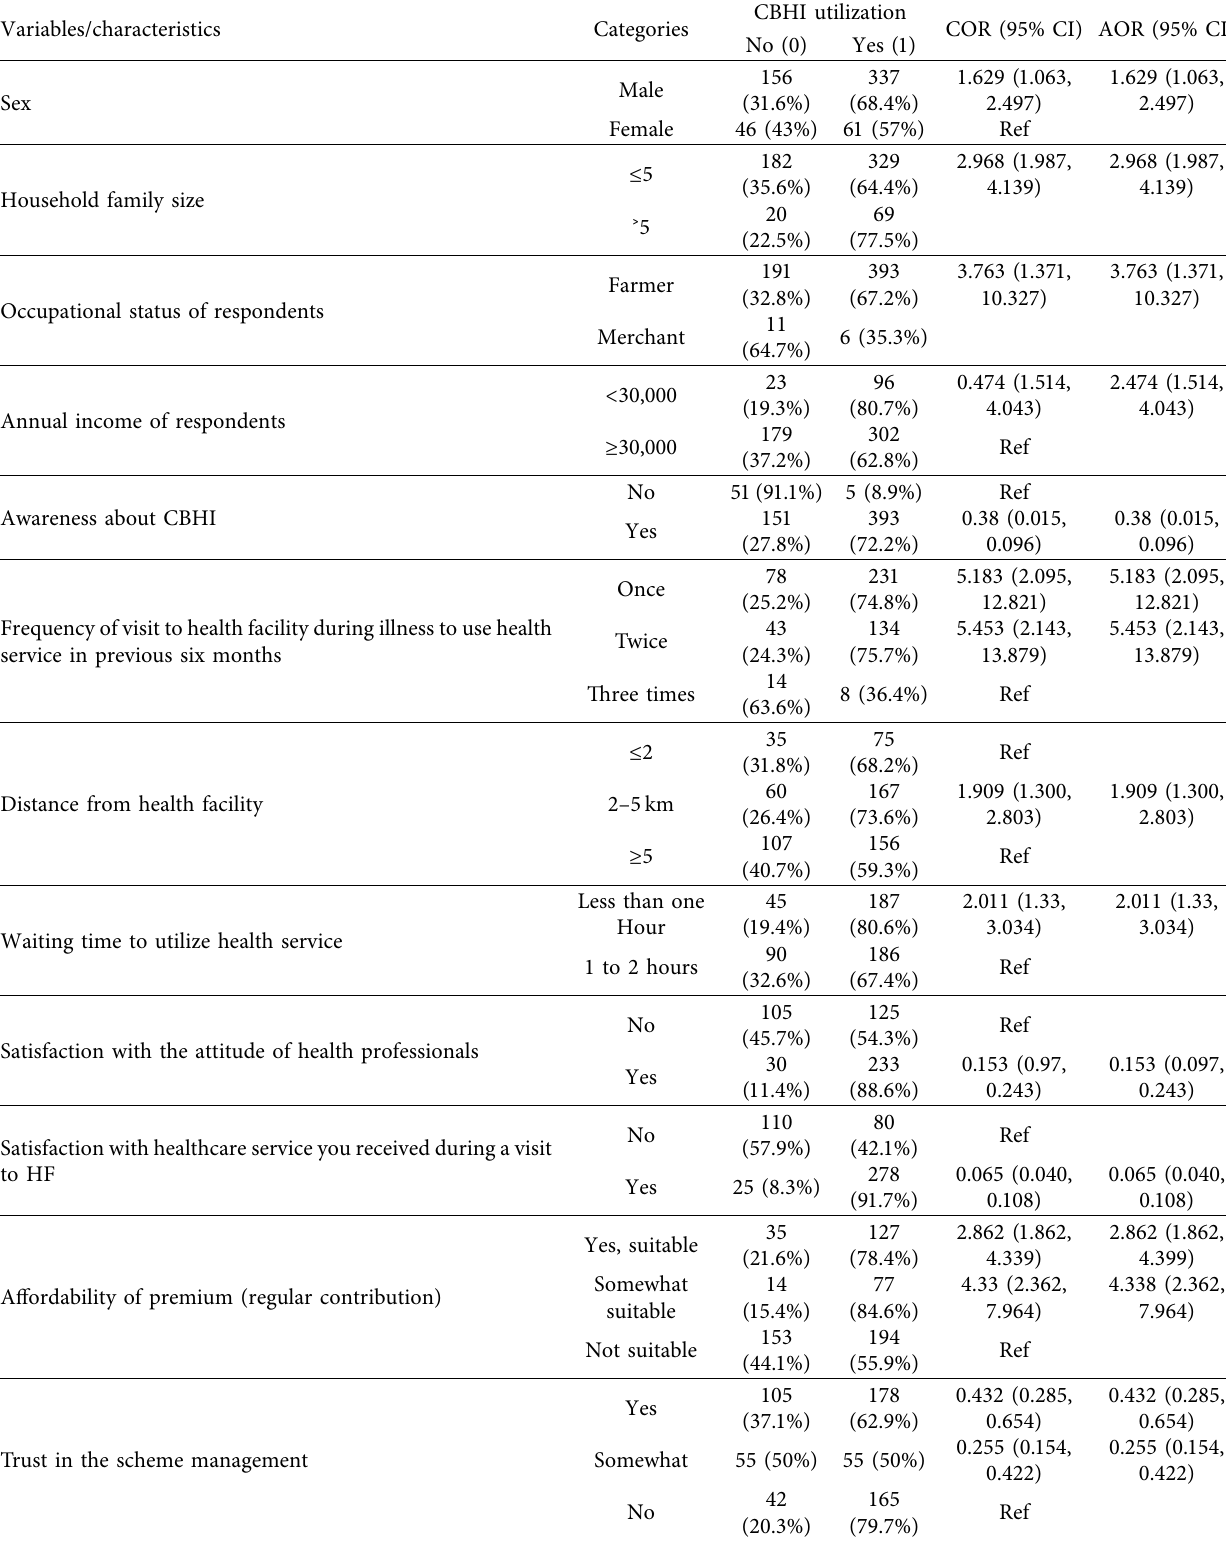
Table 4: Multivariate analysis of factors associated with CBHI utilization among rural households in Akaki District,